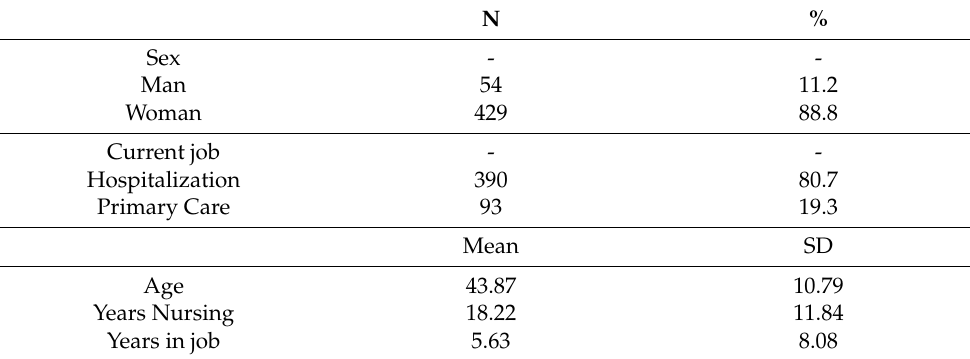
Table 1. Descriptive analysis of the socio-demographic data.